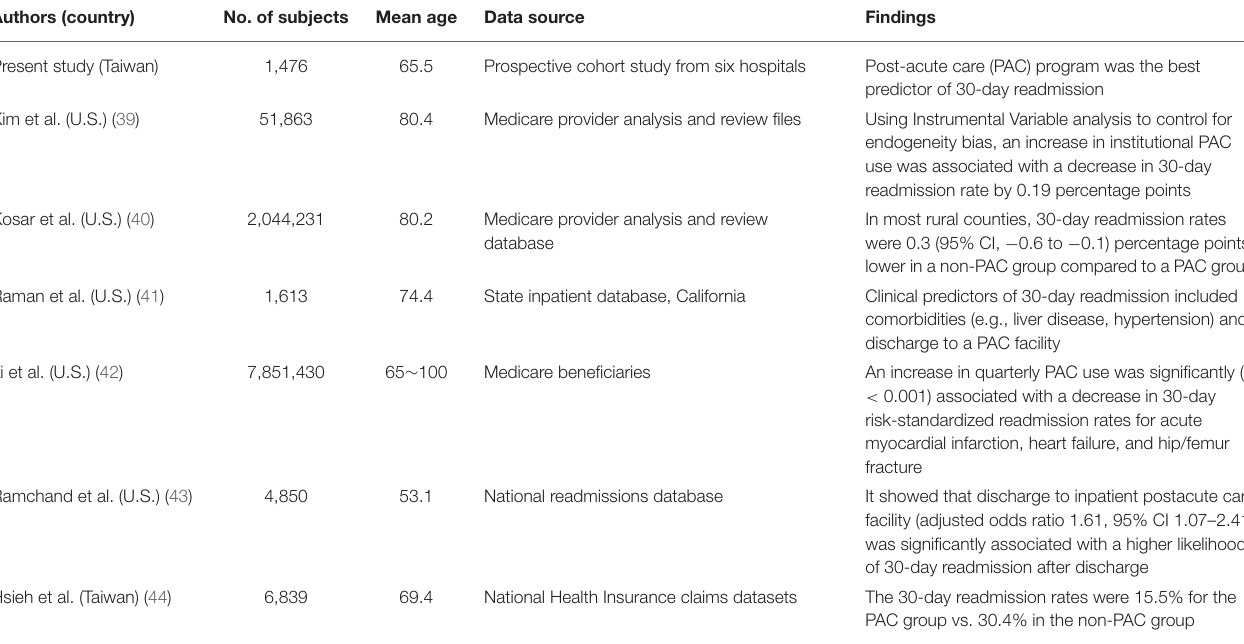
TABLE 7 | Reported associations between post-acute care (PAC) for stroke and 30-day readmission. Authors